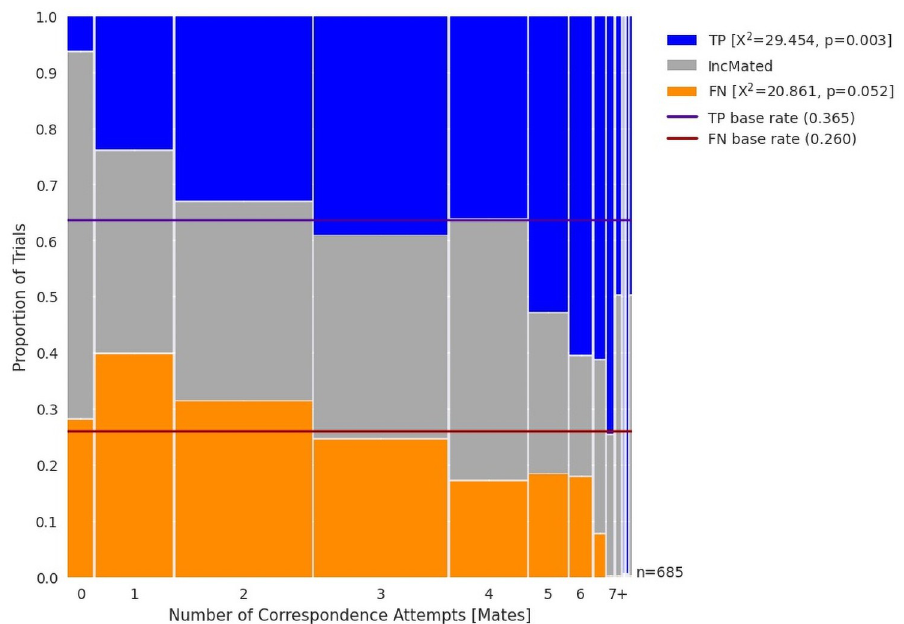
Fig 5. Mosaic plot of outcomes by number of correspondence attempts as estimated by the TECA model. TP outcomes are associated with a greater number of correspondence attempts.